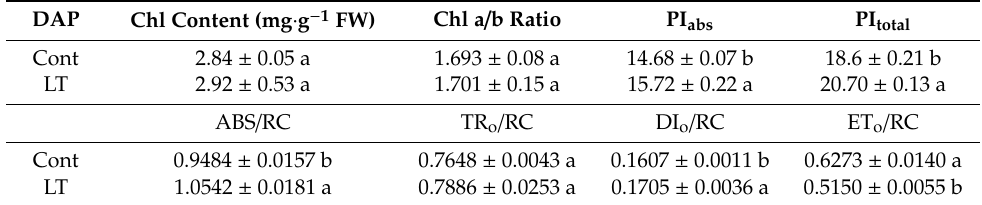
Table 1. Chlorophyll (Chl) content and Chlorophyll Fluorescence index under control (Cont) and low temperature (LT) conditions.